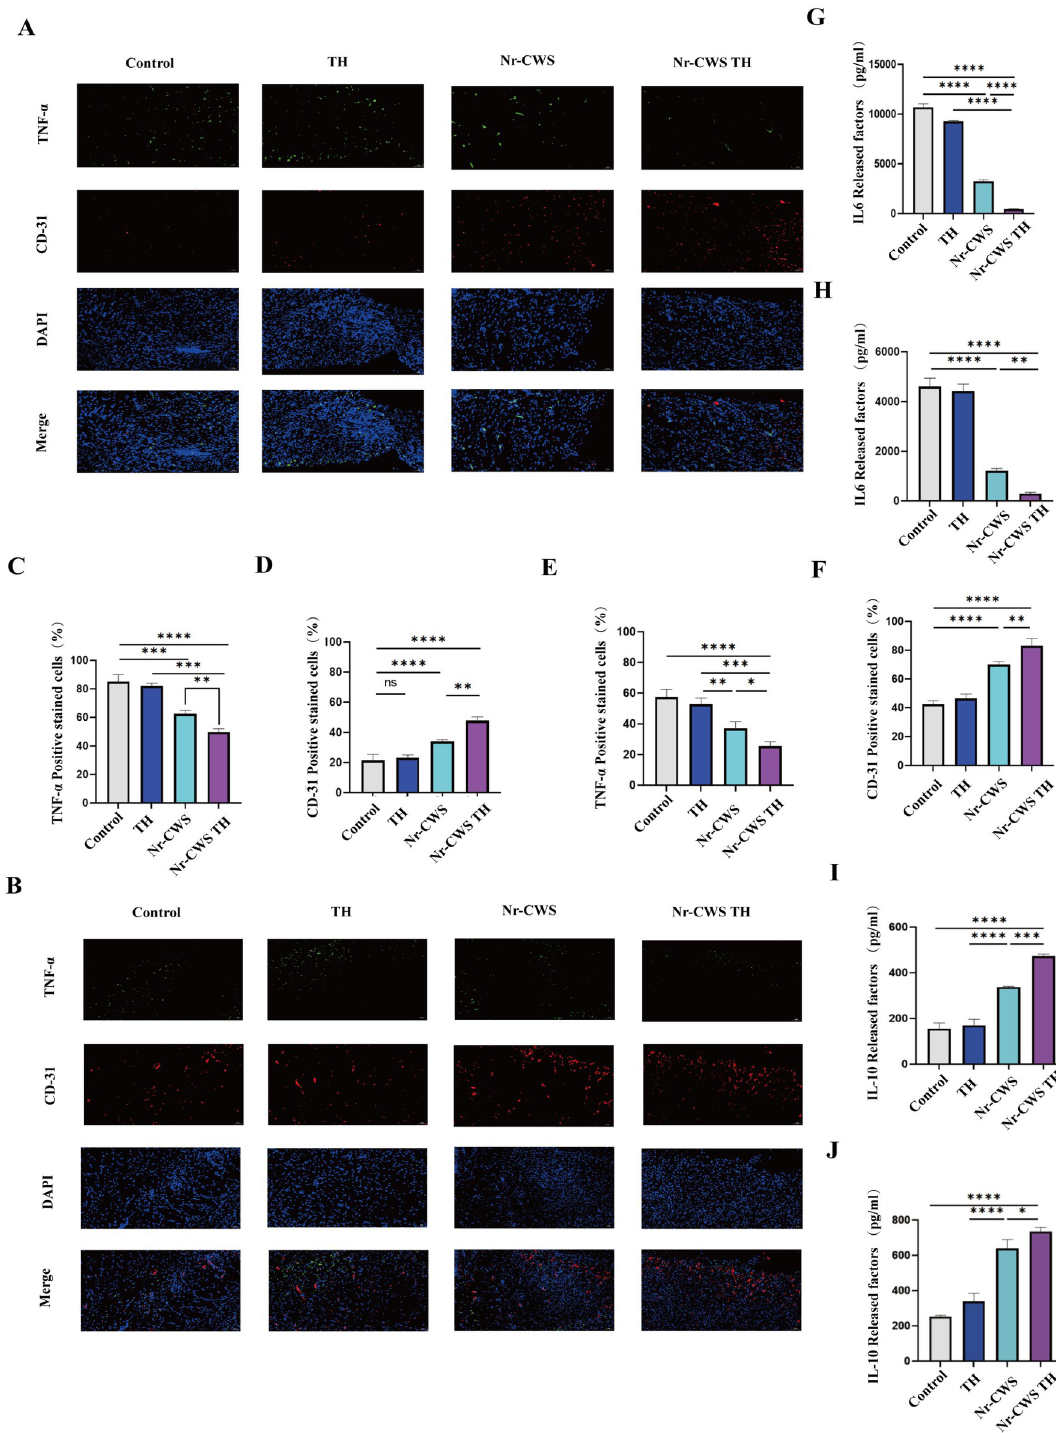
Fig 5. The tissue fluorescence staining and Elisa of neonatal epidermis. A, B) The neonatal epidermis was taken for tissue fluorescence staining, including TNF- α (green), CD31 (red), and cell nucleus (blue) on the sixth day (A) and on the fourteenth day (B). Scale bar = 50 μ m. Scale bar = 50 μ m. C,D) Statistical analysis of the TNF- α and CD-31 on the sixth day. E, F) Statistical analysis of the TNF- α and CD-31 on the fourteenth day. G, H) ELISA detected expression of IL6 in the wound healing tissue on sixth day (G) and 14th day (H). � p < 0.05, �� p < 0.01, ��� p < 0.001, ���� p < 0.0001. I, J) ELISA detected expression of IL10 in the wound healing tissue on sixth day (E) and 14th day (F). � p < 0.05, �� p < 0.01, ��� p < 0.001, ���� p < 0.0001.